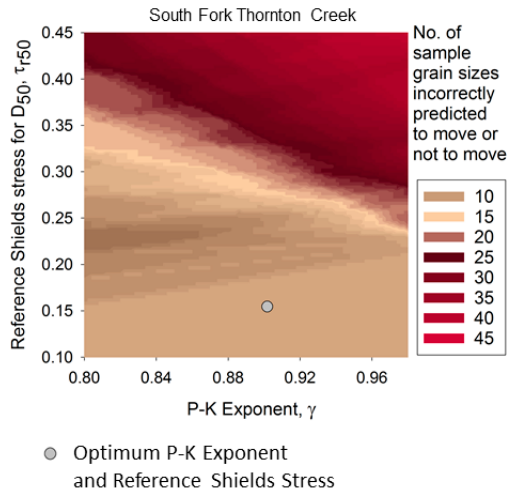
Figure 7. Grain movement prediction error for South Fork Thornton Creek. Prediction error is the count of all grain sizes, in all samples, where the model predicted sediment movement when none was measured, or where sediment was measured but none was predicted. Smaller numbers signify greater accuracy in predicting grain movement. There were a total of 52 measurements by grain size in the seven available bedload samples.